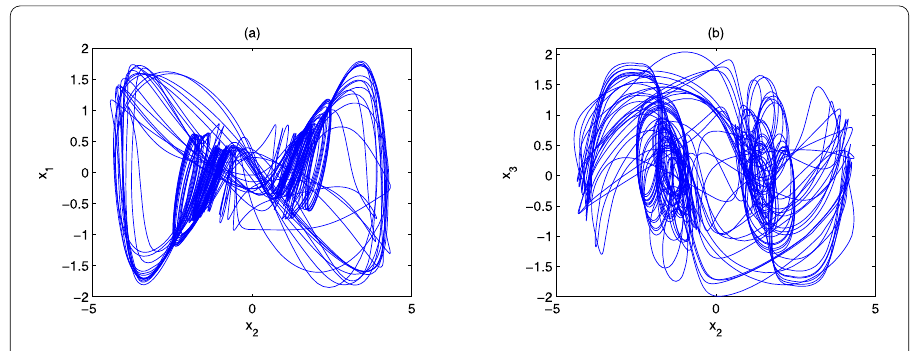
Figure 2 Phase portraits of drive system: ( a ) x 2 – x 1 plane; ( b ) x 2 – x 3